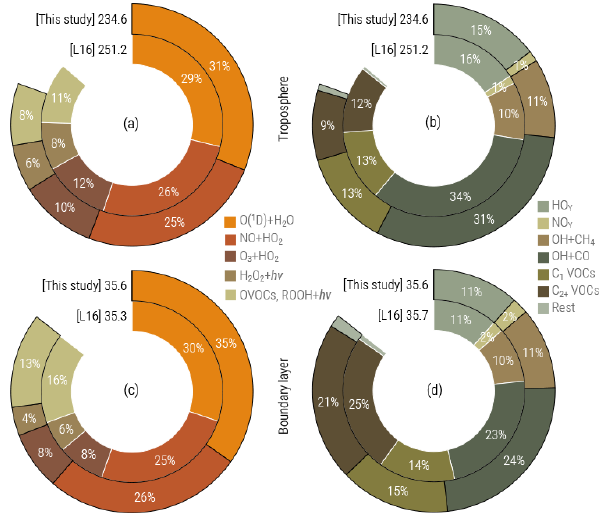
Figure 15. Simulated OH production (a, c) and sink (b, d) by cate- gory in the troposphere (a, b) and boundary layer (c, d) in this study and the study of Lelieveld et al. (2016) (denoted L16). Values are annual totals (in Tmolyr − 1 ) for 2010. Percentages denote fractions attributed to particular categories (see L16 for details).